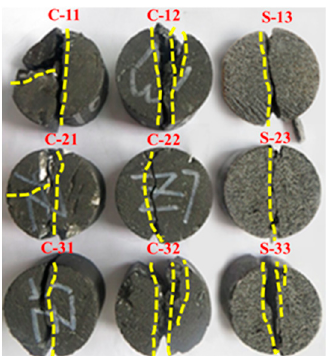
Figure 9. Failure modes observed in coal and sandstone specimens under the Brazilian test.